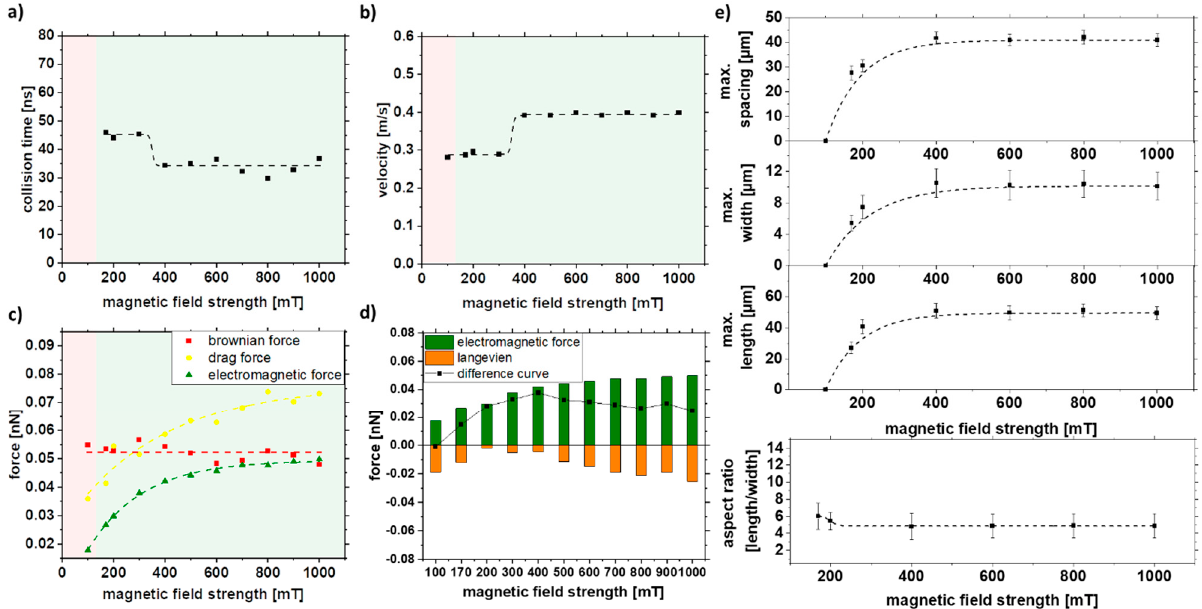
Figure 8. COMSOL simulation data of ( a ) collision time, ( b ) velocity, and ( c , d ) forces in dependence of the external magnetic field strength and experimental validation of ( e ) length, width, spacing, and aspect ratio of strands as a function of magnetic field strength in 5% PMMA solution.